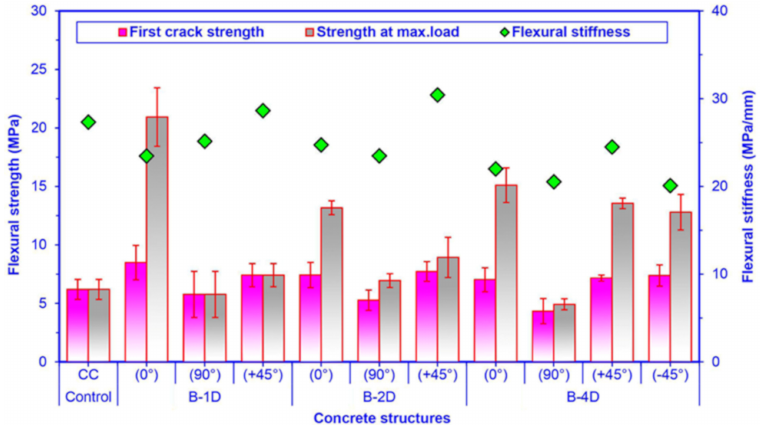
Figure 11. Off-axis flexure properties of all multiaxis 3D basalt